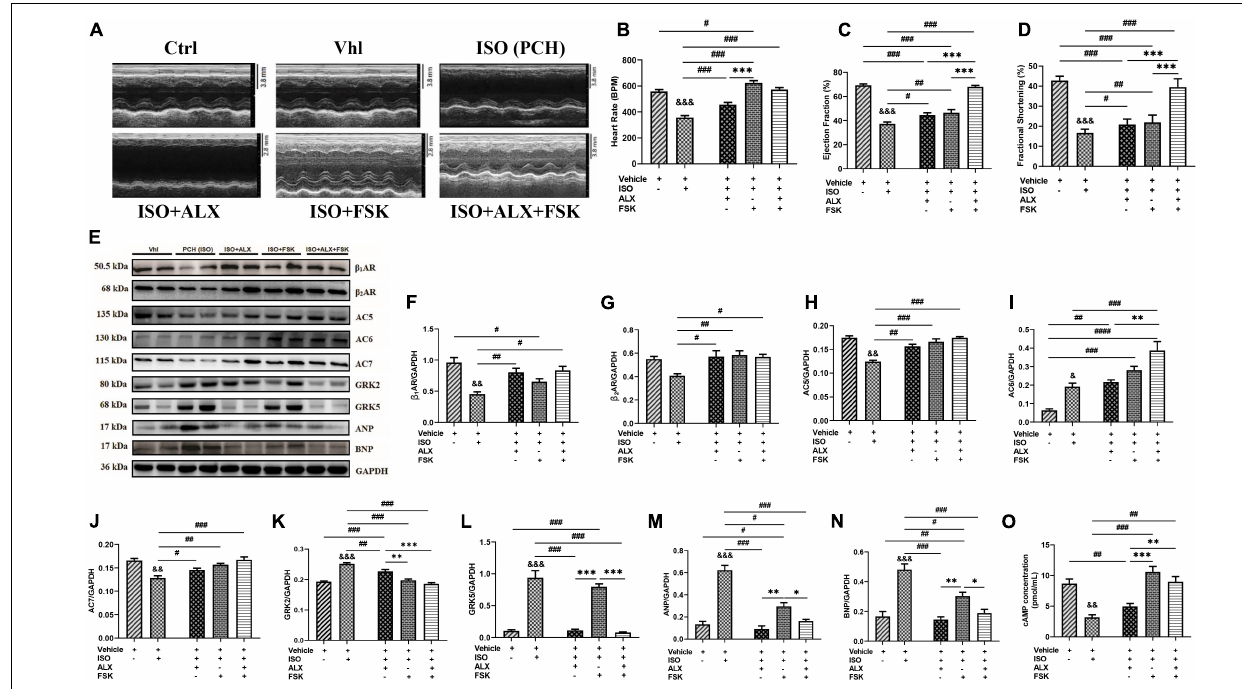
FIGURE 3 | ALX and FSK combination attenuates left ventricular systolic dysfunction (LVSD) in mice during CCS by normalizing protein expressions. (A) Representative short-axis view M-mode echocardiogram imaging from Ctrl, Vhl, isoproterenol (ISO), ISO + ALX, ISO + FSK, and ISO + ALX + FSK. (B – D) Graphical presentations of heart rates, ejection fraction, and fractional shortening assessments from all models. The Vhl mice group is representative of the Ctrl mice group in the graphical presentations due to similarity in their data. The therapeutic groups are ALX treatment, FSK treatment, and ALX and FSK combination treatment ( n = 10–11 hearts per treatment group). (E – N) Representative Western blots and graphical presentation of β ARs, ACs, GRKs, ANP, and BNP, were assessed from all groups ( n = 4 hearts per treatment group). Western blots were performed in triplicates, and each protein band in the representative blot is an independent biological sample. (O) Graphical represents of cAMP concentrations evaluated by ELISA ( n = 9 mice per treatment group). ∗ p < 0.05, ∗∗ p < 0.01, ∗∗∗ p < 0.001 among the therapeutic groups; && p < 0.01, &&& p < 0.001 vs. Vhl; # p < 0.05, ## p < 0.01, ### p < 0.001 vs. the therapeutic groups. Data are expressed as mean ± SEM. Data were analyzed using one-way ANOVA, followed by Tukey’s post hoc analysis. Abbreviations: β ARs, β -adrenergic receptors; ACs, adenylyl cyclases; GRKs, G-protein-coupled receptor kinases; ANP, atrial natriuretic peptide; BNP, brain natriuretic peptide.